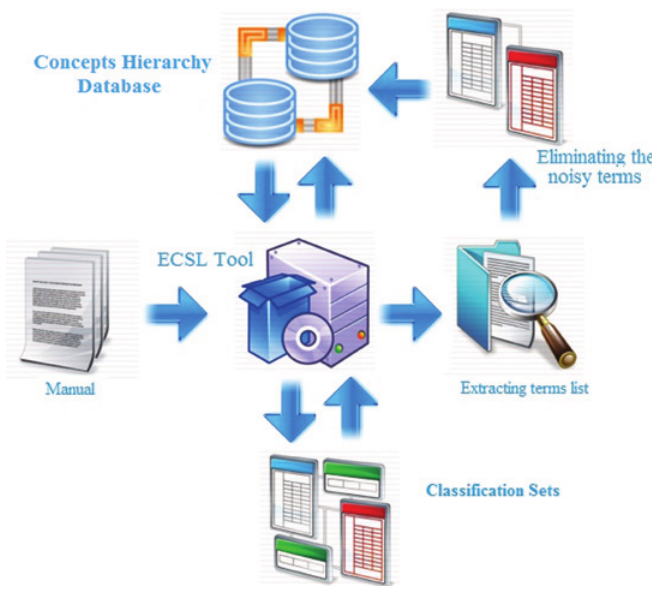
Figure 2. An Overview of the Concept Hierarchy